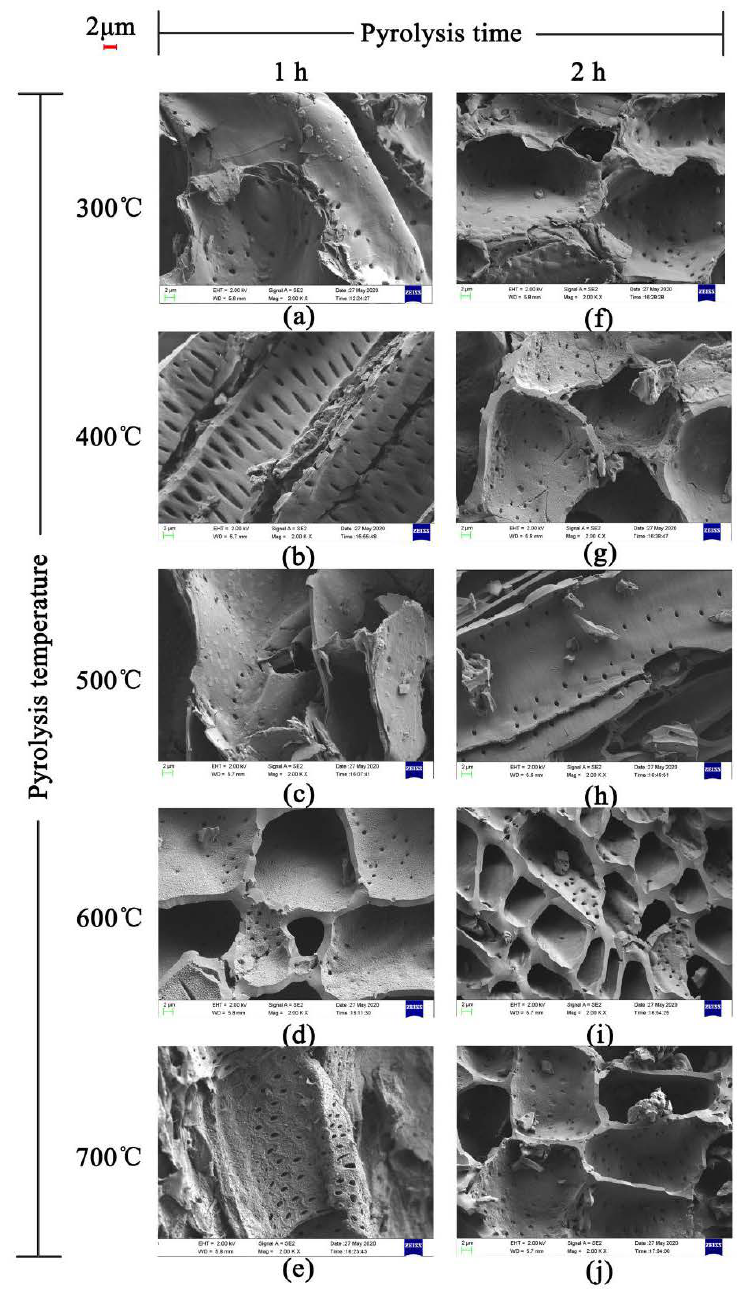
Figure 2. SEM images of JB at 2000 times. ( a ) 300 °C/1 h, ( b ) 400 °C/1 h, ( c ) 500 °C/1 h, ( d ) 600 °C/1 h, ( e ) 700 °C/1 h, ( f ) 300 °C/2 h, ( g ) 400 °C/2 h, ( h ) 500 °C/2 h, ( i ) 600 °C/2 h, ( j ) 700 °C/2